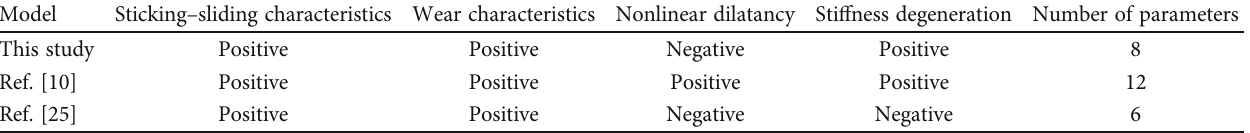
Table 6: Constructive models of the structural plane in the rock mass under a cyclic shear load.